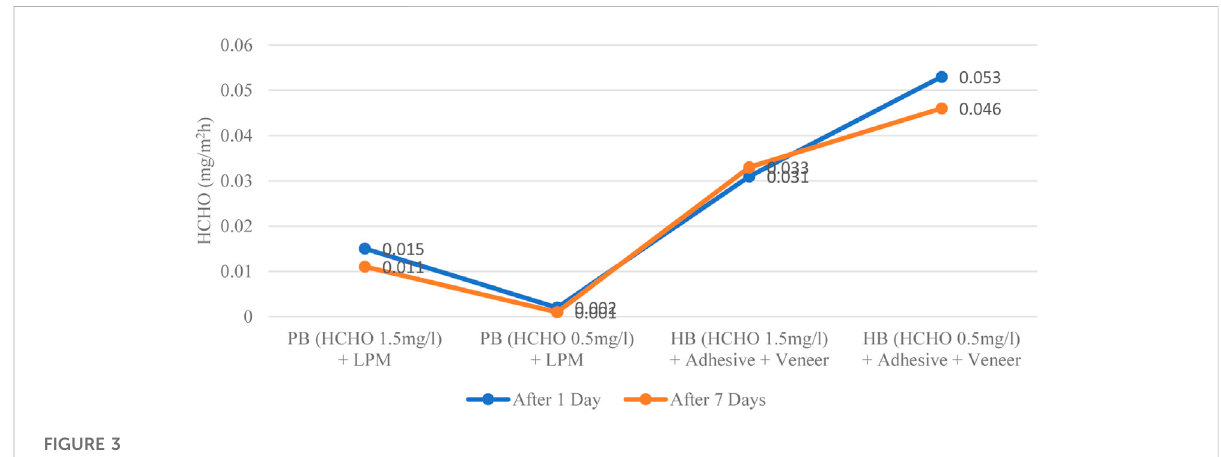
FIGURE 3 HCHO emission intensity according to different raw